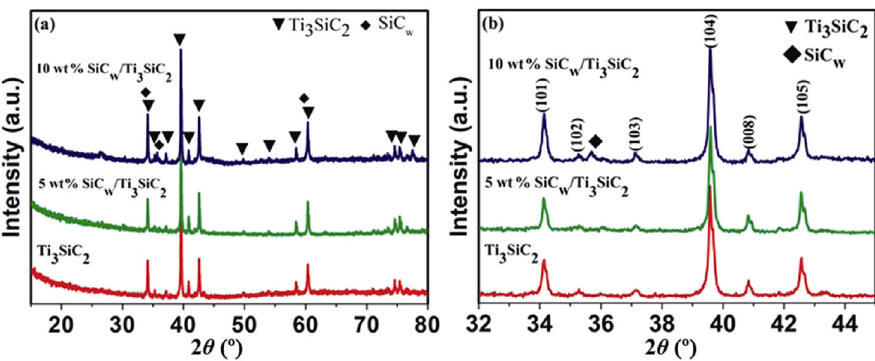
Fig. 4 XRD patterns of the SiC w /Ti 3 SiC 2 and pure Ti 3 SiC 2 for 2 θ = (a) 20  –80  and (b) 32  –45  after SPS at 1350 ℃